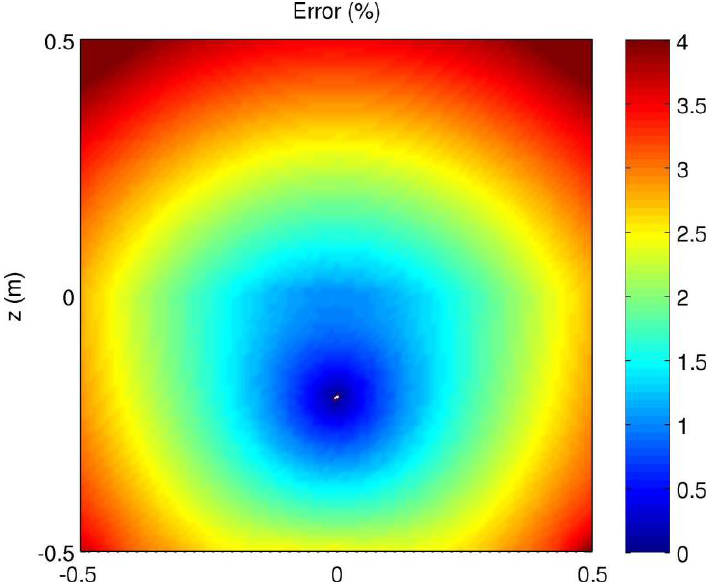
Figure 4. Numerically simulated electric potential distribution, for a single current source I with considered values I = 1 A and ξ = (0, 0, −20 cm) T .